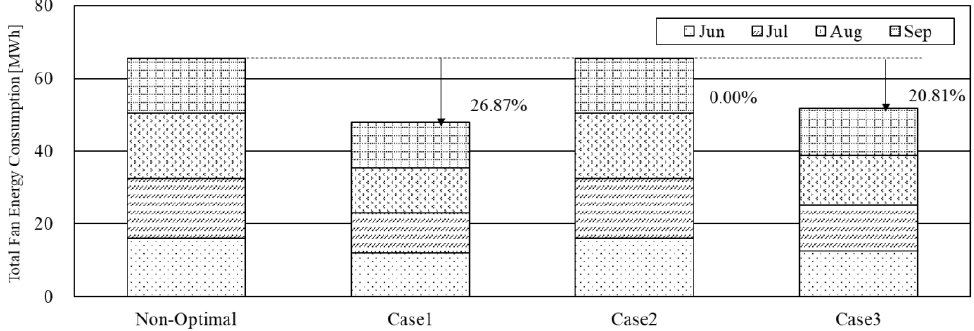
Figure 10. Comparison of fan energy consumption between normal operation mode and optimal operation modes for June through September.